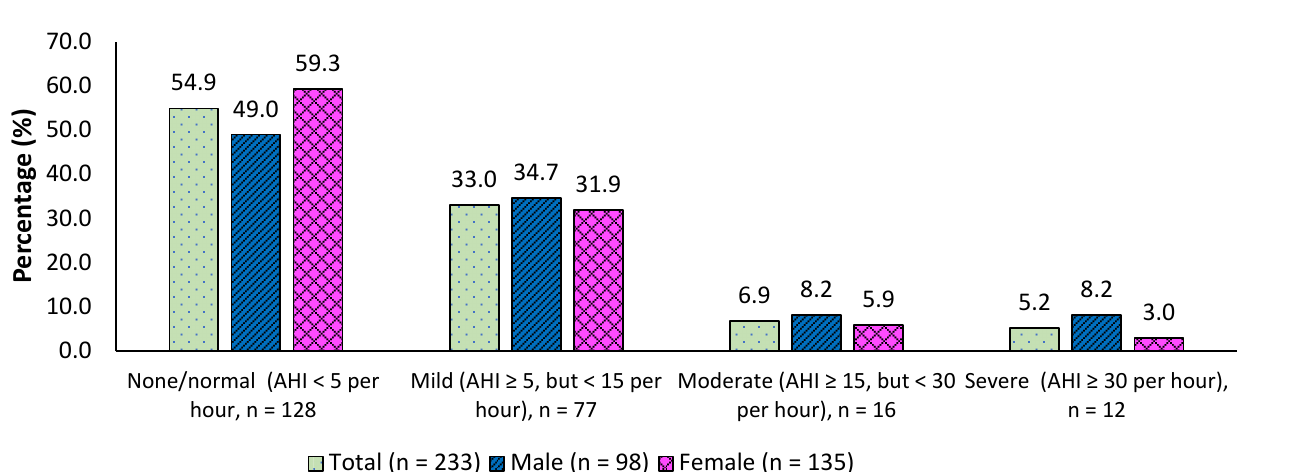
Figure 1. Prevalence of Severity of OSA based on Apnea Hypopnea Index (AHI).